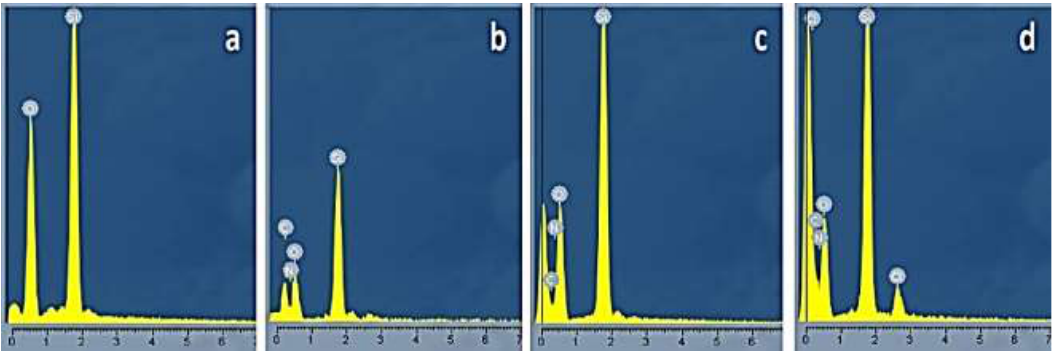
, (d) MSNPs-NH , (e) HSNPs-CHO, (f) HSNPs-COOH, (g) 2 2 MSNPs-COOH